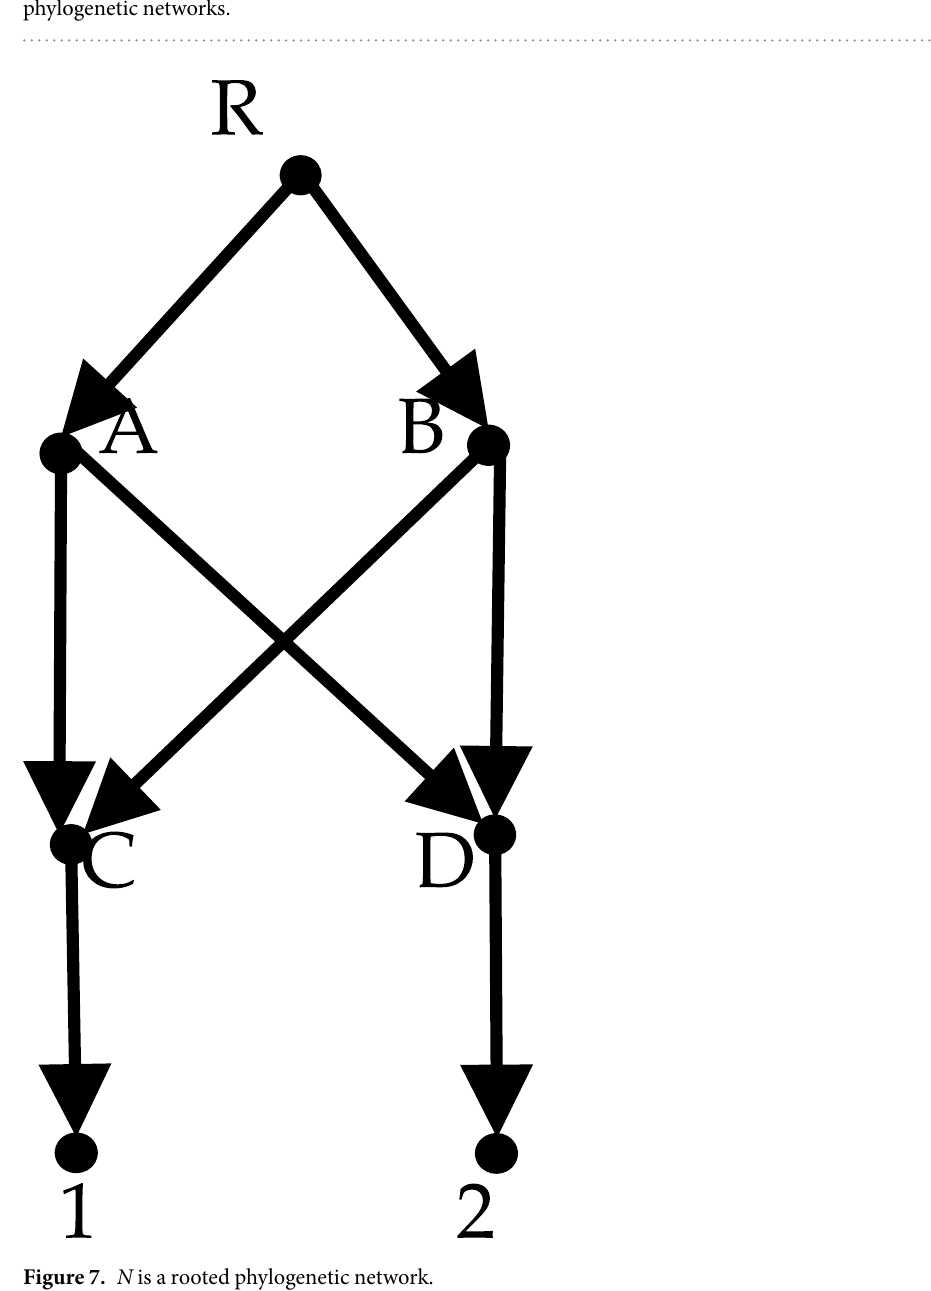
Figure 7. N is a rooted phylogenetic